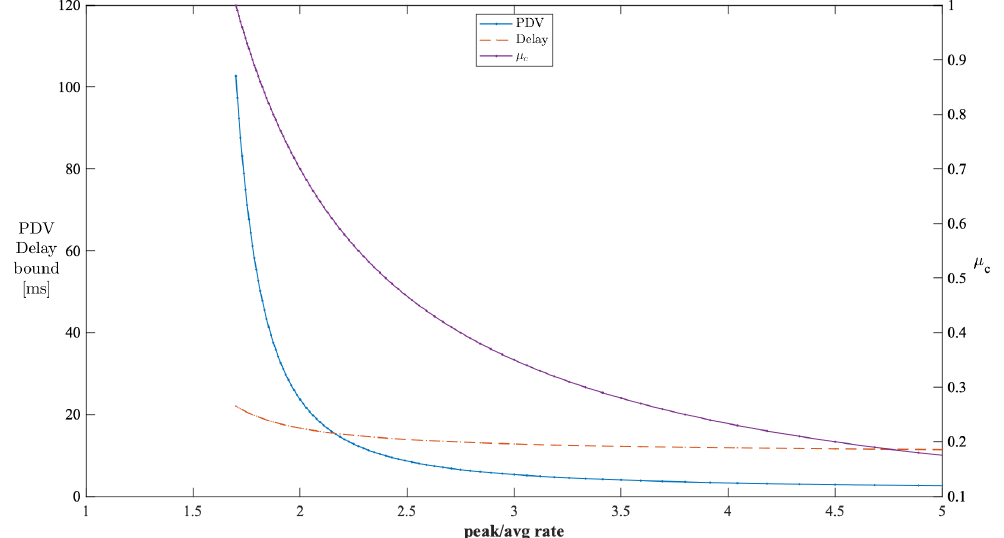
Figure 11. Impact of the peak-to-average rate ratio of cross traffic on the PDV bound in a single-stage network (constant λ c